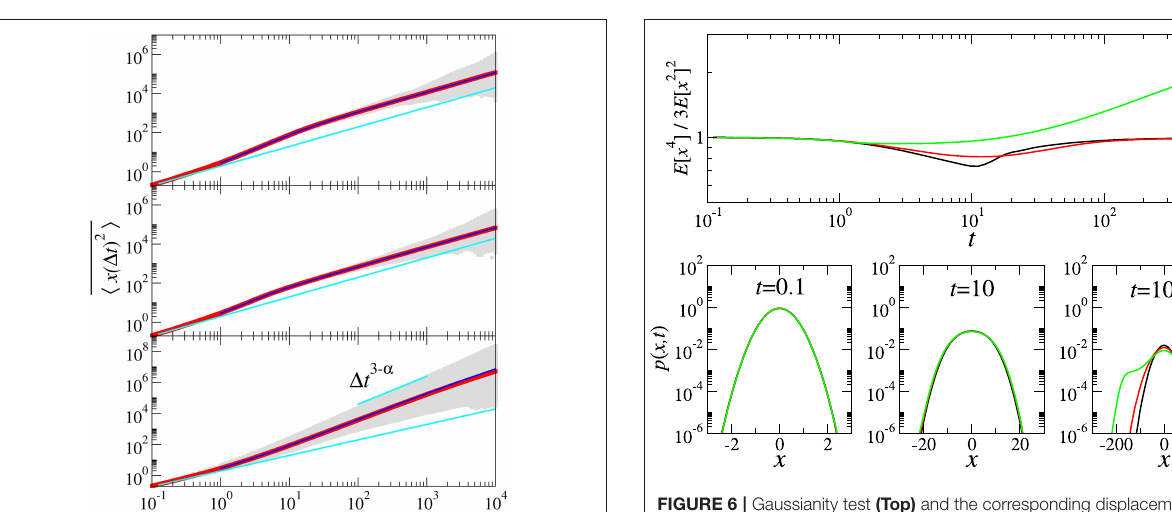
FIGURE 6 | Gaussianity test (Top) and the corresponding displacement PDFs p ( x , t ) (Bottom) for the overdamped Langevin motion of Equation (27). In the panels, each line represents, respectively, the result for the poissonian (red), FIGURE 5 | Time-averaged MSDs for the overdamped Langevin dynamics gaussian (black), and the power-law (green) PDF of P ( τ ). Parameters in P ( τ ) from Equation 27. From Top to Bottom the cases for the poissonian, gaussian, were used as in the previous simulation for MSDs. The displacement PDFs and the power-law PDFs of P ( τ ), respectively. Gray dots show the were obtained from 10 8 simulation runs with T time-averaged MSD curves from single trajectories generated from simulation D σ 1. The basic units are: [ x ] = ˜ = and the solid (red) line represents their average over 10 6 realizations. Blue lines are the theoretical curves of Equation 35. The Langevin simulation was carried out with timestep δ t 0.01, D 1, and T 10 5 . For the f ( t ) the same PDFs = = = of P ( f ) and P ( τ ) informed in Figures 3 , 4 were used. The units in our D / D / √ σ , [ t ] σ . overdamped Langevin simulation (Equation 27) are: [ x ] ˜ = ˜ =